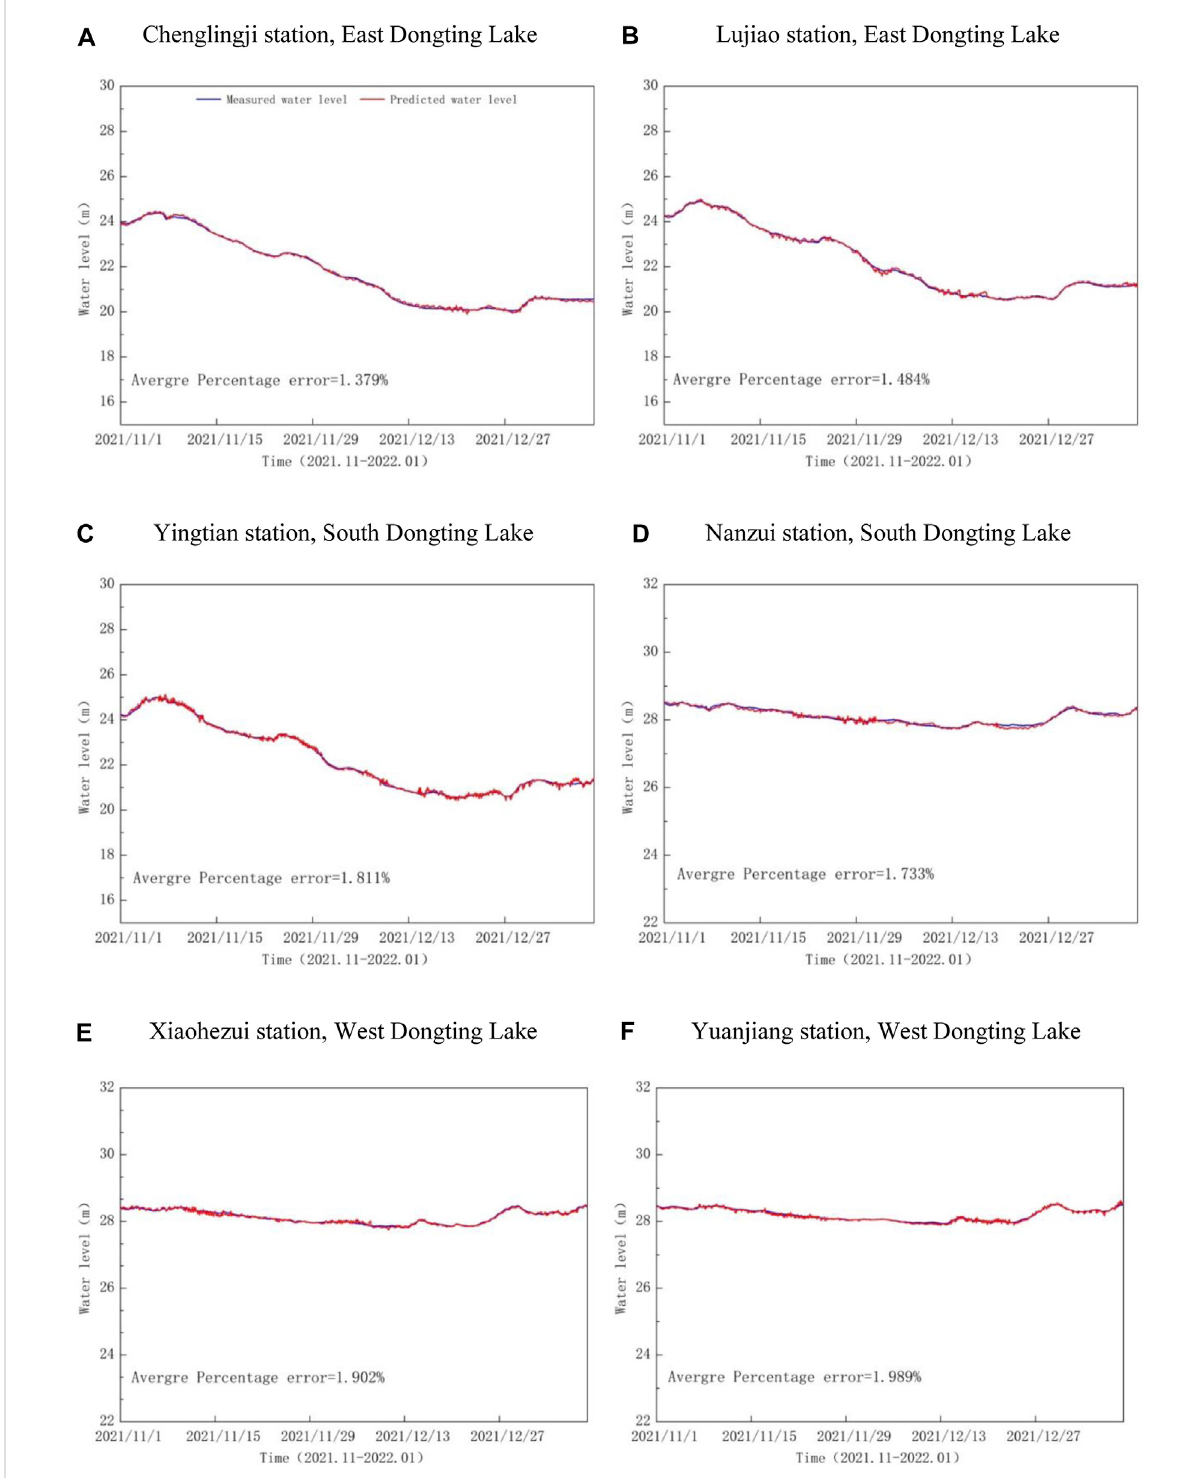
FIGURE 7 Real-timewaterlevelforecastineachrepresentativestationsinWest,SouthandEastDongtingLake. (A) Chenglingjistation,EastDongtingLake. (B) Lujiao station, East Dongting Lake. (C) Yingtianstation, South Dongting Lake. (D) Nanzui station, South Dongting Lake. (E) Xiaohezui station, West Dongting Lake. (F) Yuanjiang station, West Dongting